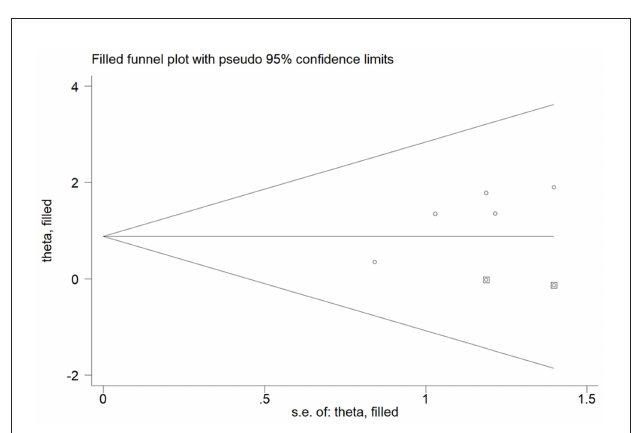
FIGURE3 Funnel plot showing the impact of elevated homocysteine level on poststroke depression. The circles alone are real studies and the circles enclosed in boxes are “filled”